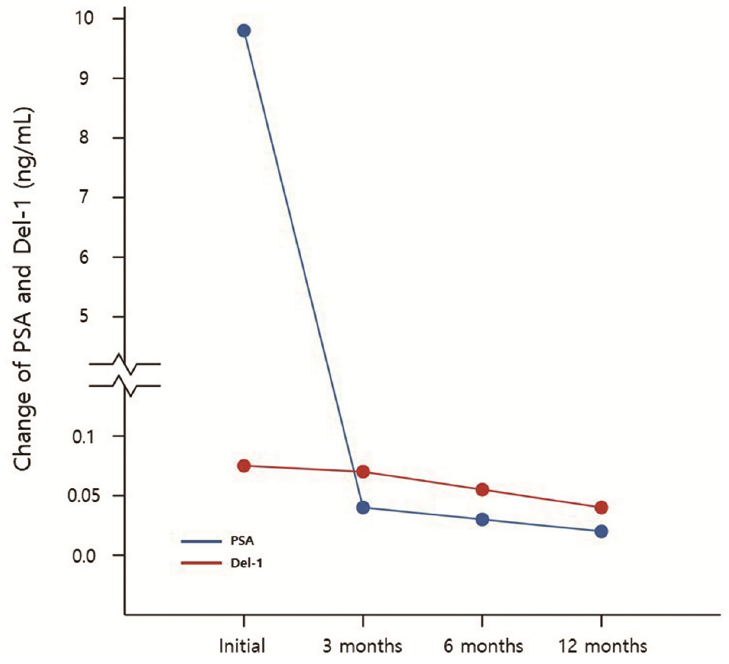
Fig 7. Change of PSA and Del-1 protein in 14 patients who underwent radical prostatectomy and did not show biochemical recurrence.